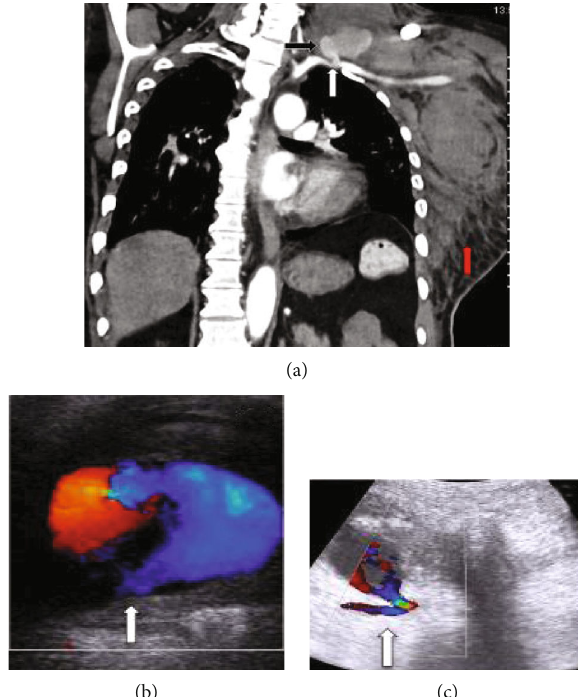
Figure 2: (a) CT coronal section showing the left subclavian artery (white arrow) with pseudoaneurysm (black arrow) and large intra- and extramuscular chest wall and left side hematoma (red arrow). (b, c) Ultrasonography showing a pseudoaneurysm originating from the subclavian artery (white